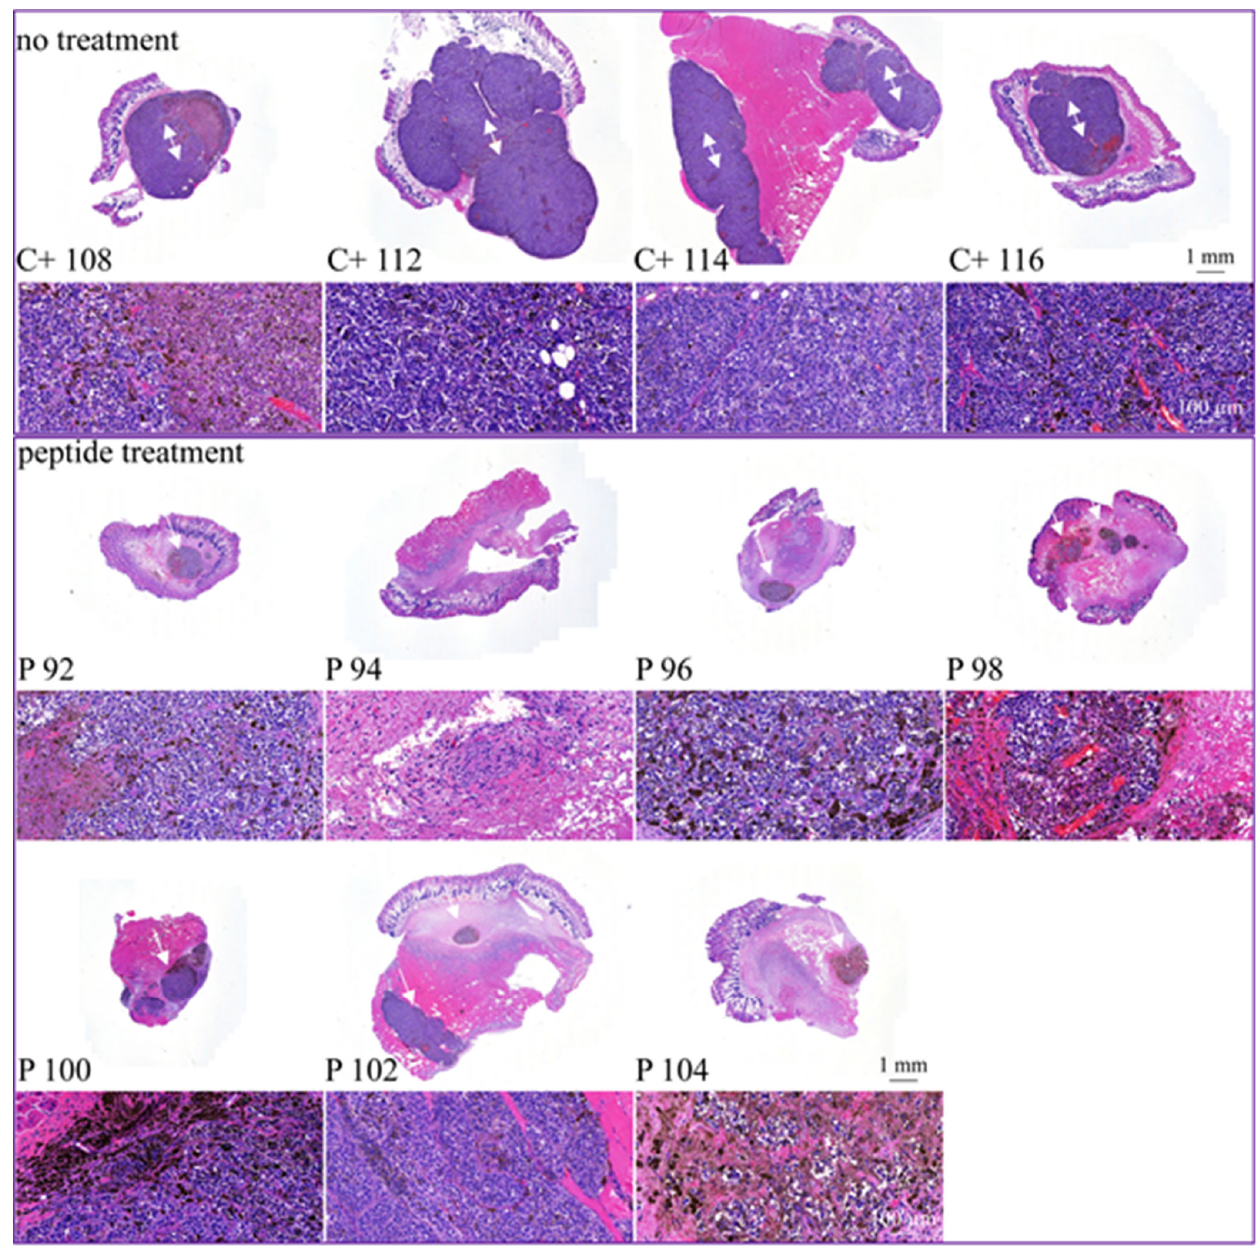
Figure 10. Histological staining of tumors of MUG-Mel2 xenografts in either tumors of control (C+, control PBS; top) C+ 108, C+ 112, C+ 114 and C+ 116 or peptide-treated (P, peptide treated; middle and bottom) P 92, P 94, P 96, P 98, P 100, P 102 and P 104. On day 15 of treatment mice were sacrificed and tumors were isolated and embedded in paraffin. Respective sections were stained with hematoxylin and eosin and tumor areas (dark violet, white double ‐ headed arrows surrounded by tumor, white single ‐ headed arrows pointing at tumor) were analyzed. Below whole tumor sections, 20 ‐ fold zooms are illustrated. Peptide treatment induces strong tumor regression with only small residual tumor areas, whereas in control tumors, tumor cells cover whole biopsy tissue and tumors are significantly larger.